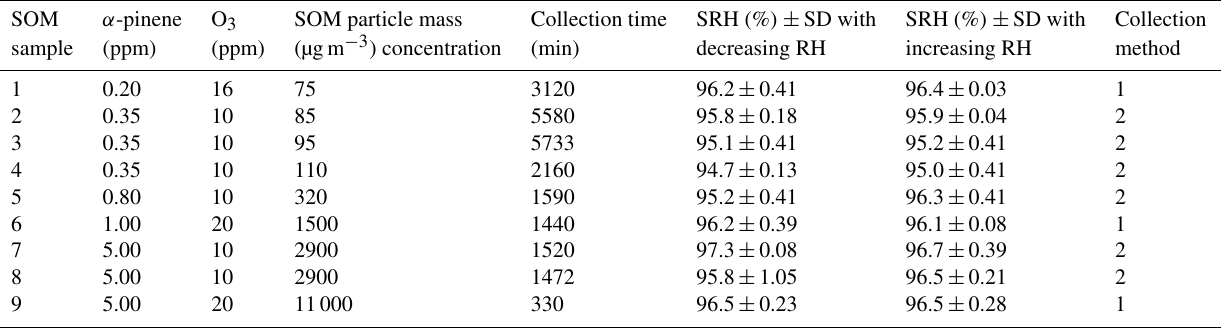
Table 1. Summary of experimental conditions for the production and collection of α -pinene-derived SOM. SOM samples 2, 3, 4, 5, 7 and 8 were collected on hydrophobic substrates using a single stage impactor. SOM samples 1, 6 and 9 were collected on hydrophobic substrates using an electrostatic precipitator. The separation relative humidity (SRH) from one to two phases is listed for each SOM. The standard deviation (stdev) is derived from several cycles of RH for different deposited particles. In cases for which the SRH was only determined for one humidity cycle (SOM samples 3–5), the error represents the maximum error reported for the other SOM samples. SOM particle mass concentration refers to the concentration of organic particles suspended in the gas phase at the time of SOM production. Collection time